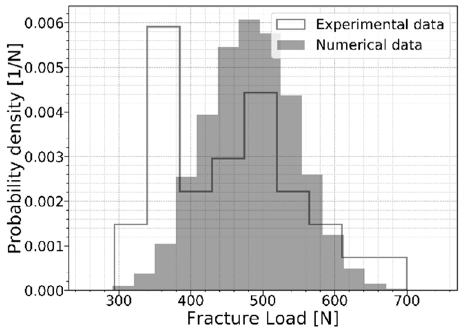
Figure 8. The normalized histogram of the fracture load.